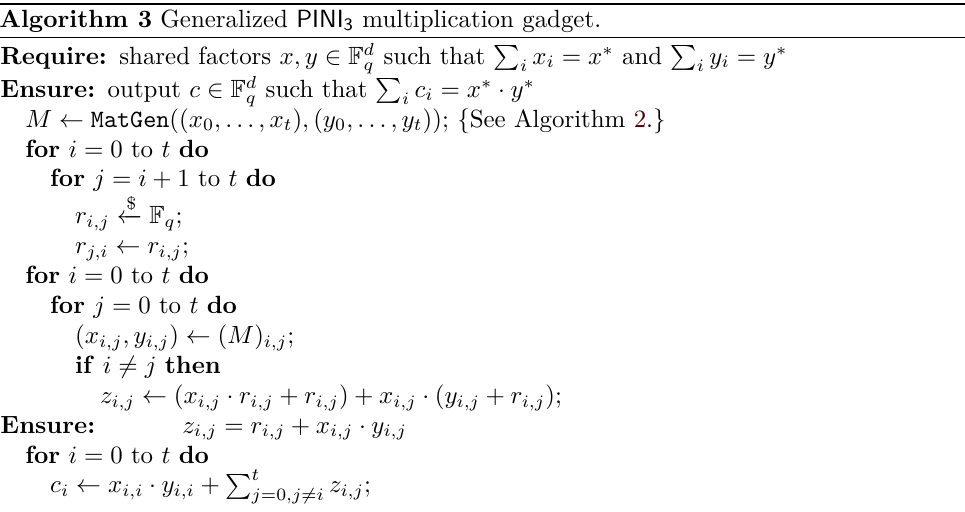
Algorithm 3 Generalized PINI 3 multiplication gadget.